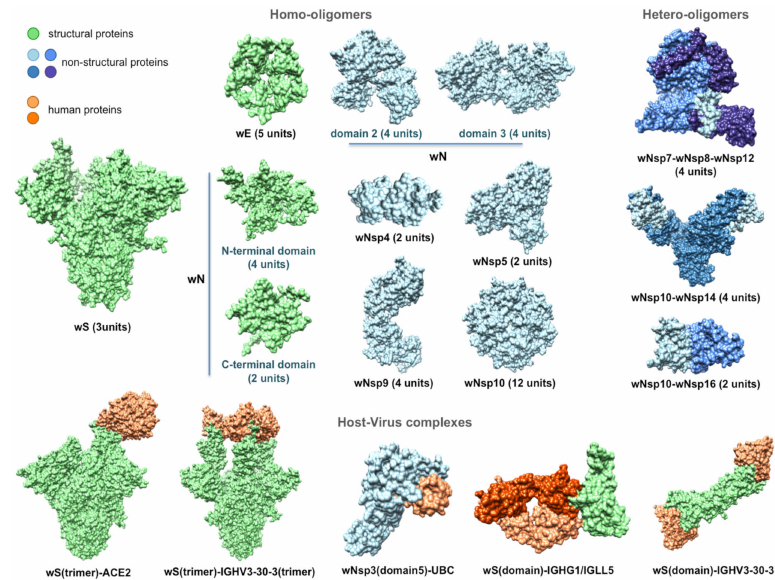
Figure 3. Structurally characterized intra-viral and host–viral protein–protein interaction complexes of SARS-CoV-2. Human proteins (colored in orange) are identified through their gene names. For each intra-viral structure, the number of subunits involved in the interaction is